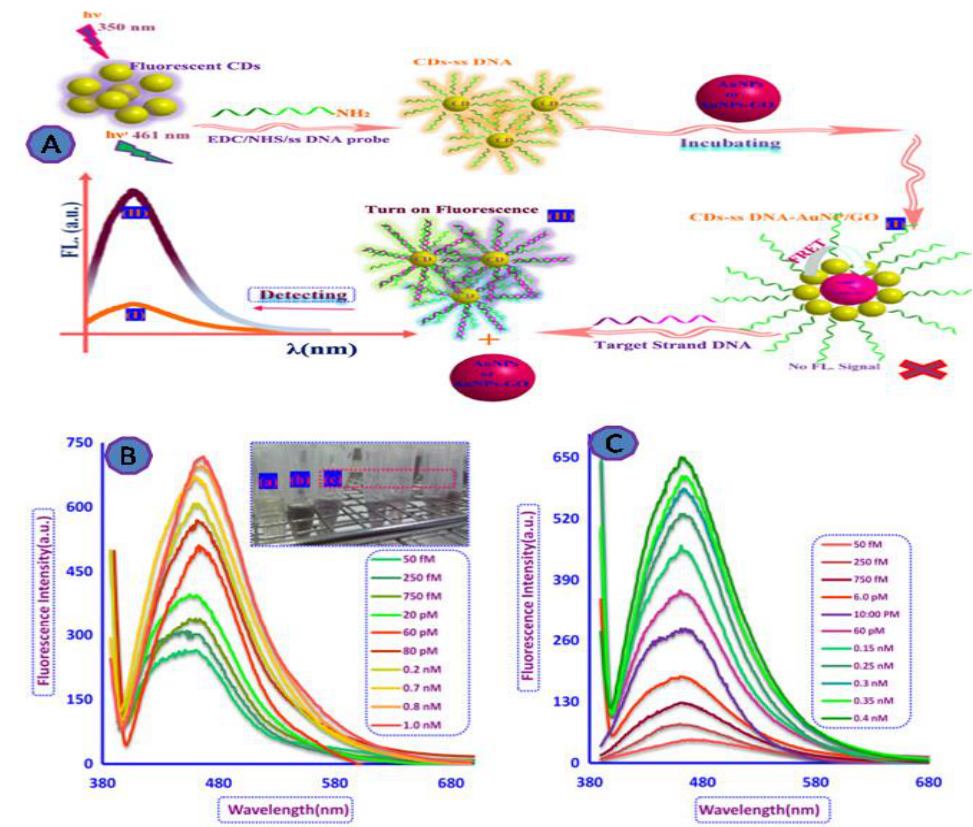
Figure 6. GO-fluorescent biosensor for HIV viral detection. ( A ) The scheme of the FRET-based detection system; ( B ) fluorescence recovery spectra of the capture probe ssDNA-CD/AuNP system in the presence of various amounts of target DNA at λ 350 nm excitation and 0.22 nM AuNPs as a quencher; ( C ) the fluorescence recovery spectra of the ssDNA-CD-AuNP/GO system in the presence of different concentrations of target DNA at excitation wavelength of 350 nm and 5 μg/mL of GO/AuNPs as quencher. Reprinted with permission from Ref. [71]. Copyright 2017, Elsevier.